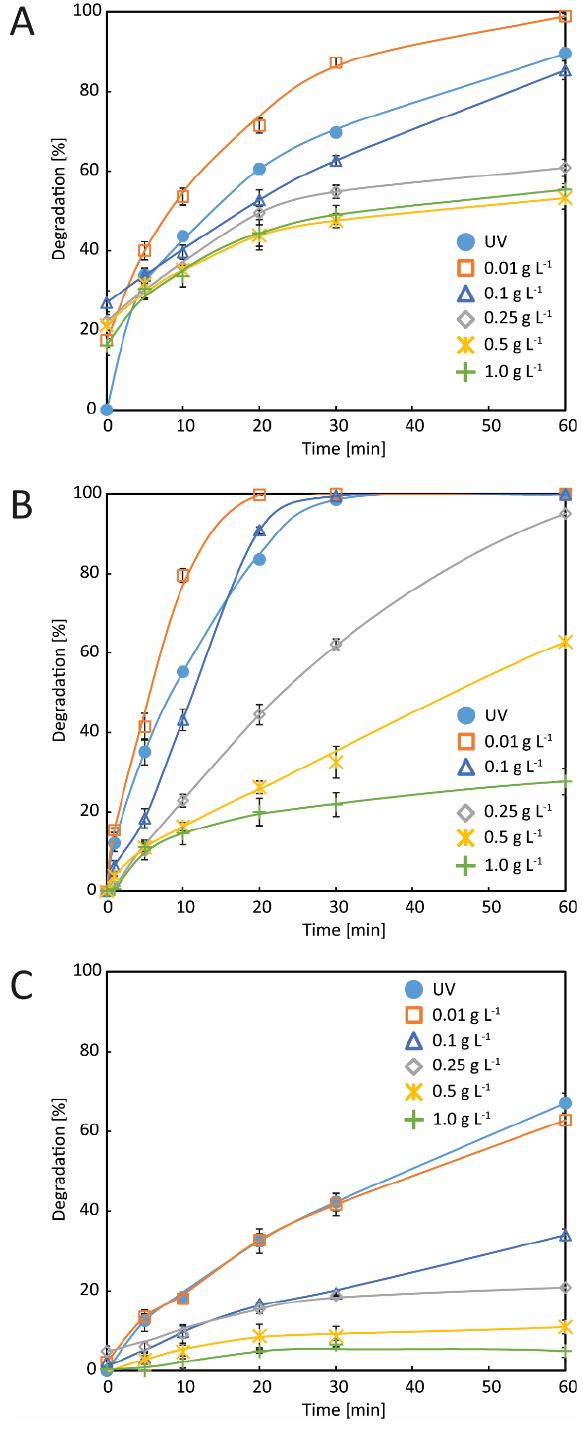
Figure 3. Removal of tested compounds during photodegradation with TiO 2 . ( A ) Degradation of BPA, ( B ) degradation of BPS, ( C ) degradation of FLC. The initial concentrations of BPA, BPS, and FLC were 10 mg L −1 .